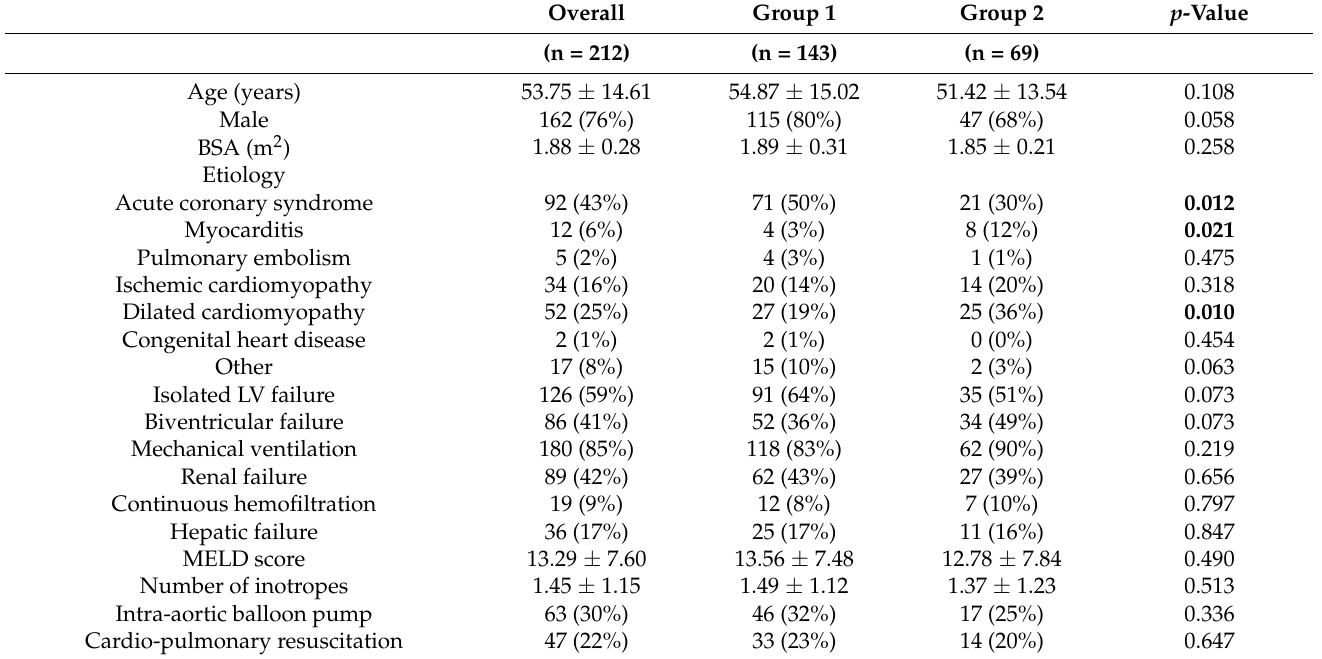
Table 1. Pre-implantation characteristics.